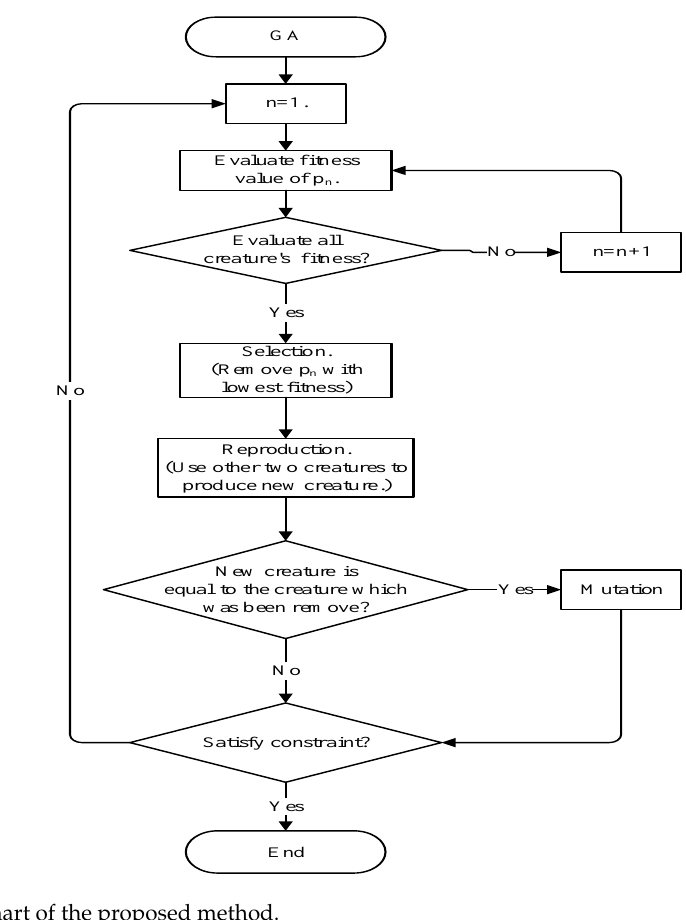
Figure 9. The flowchart of the proposed method.